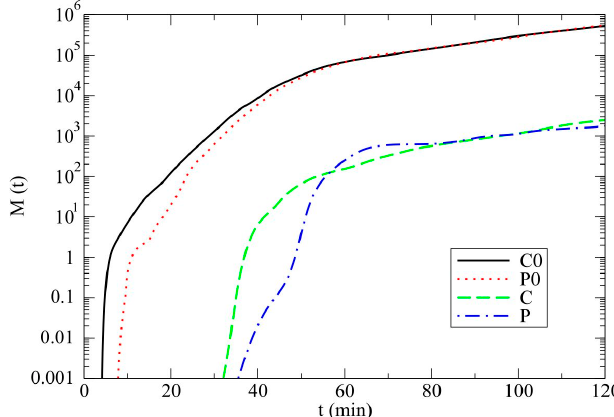
Figure 7. As in Figure 5, but for the cumulative sum of the mass contribution, M (tonnes) to rain based on accretion of cloud droplets.